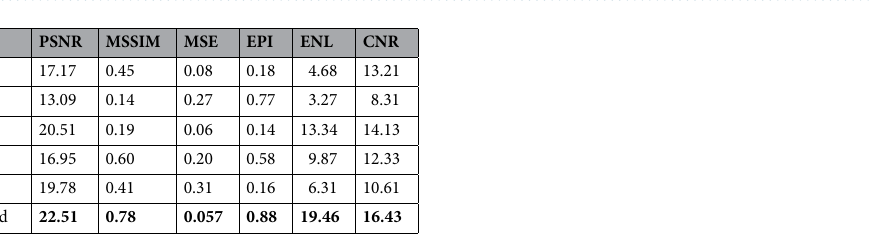
Table 2. Experiment results of our adaptive-SIN and other state-of-the-art algorithms are evaluated based on PSNR, MSSIM, MSE, EPI, ENL and CNR. The bold numbers mean the best result compared with other